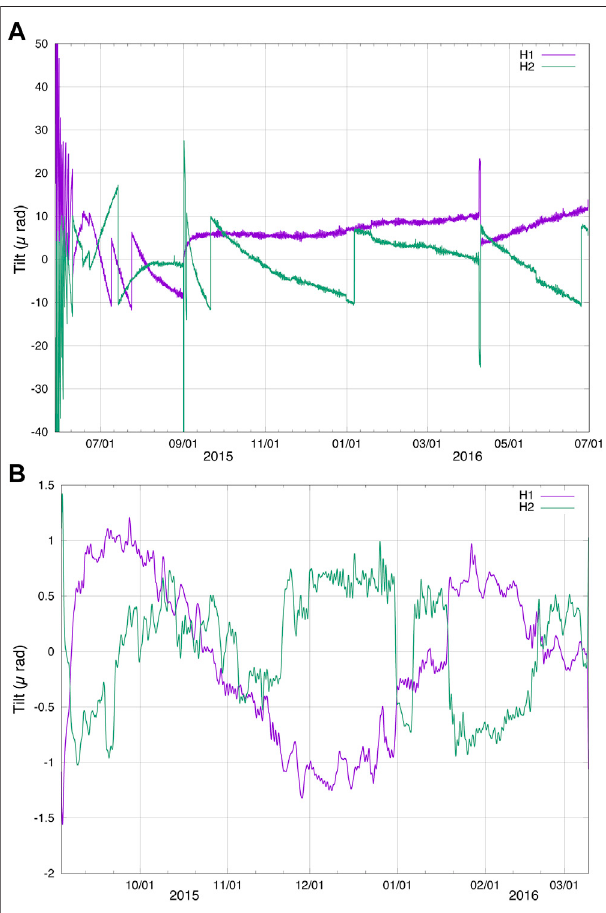
FIGURE 9 | An example of the tilt measurement using the BBOBS. The BBOBSmaybeusedfortiltmeasurementinthesamemethodastheBBOBST- NX. One example is shown here, which was obtained by the BBOBS deployed neartheIzu-Ogasawaratrench( Figure6A ). (A) The whole “ RAW ” tiltdata were only converted from the mass position data, which includes several mass centering steps. However, the H1 component in the middle part seemed stable for 7 months. (B) The stable period mentioned above was processed with the same method as in Figure 6C . Except for a few parts of mass centering operations inthe H2component, usual tilt fl uctuation remainedsmaller than1 µ